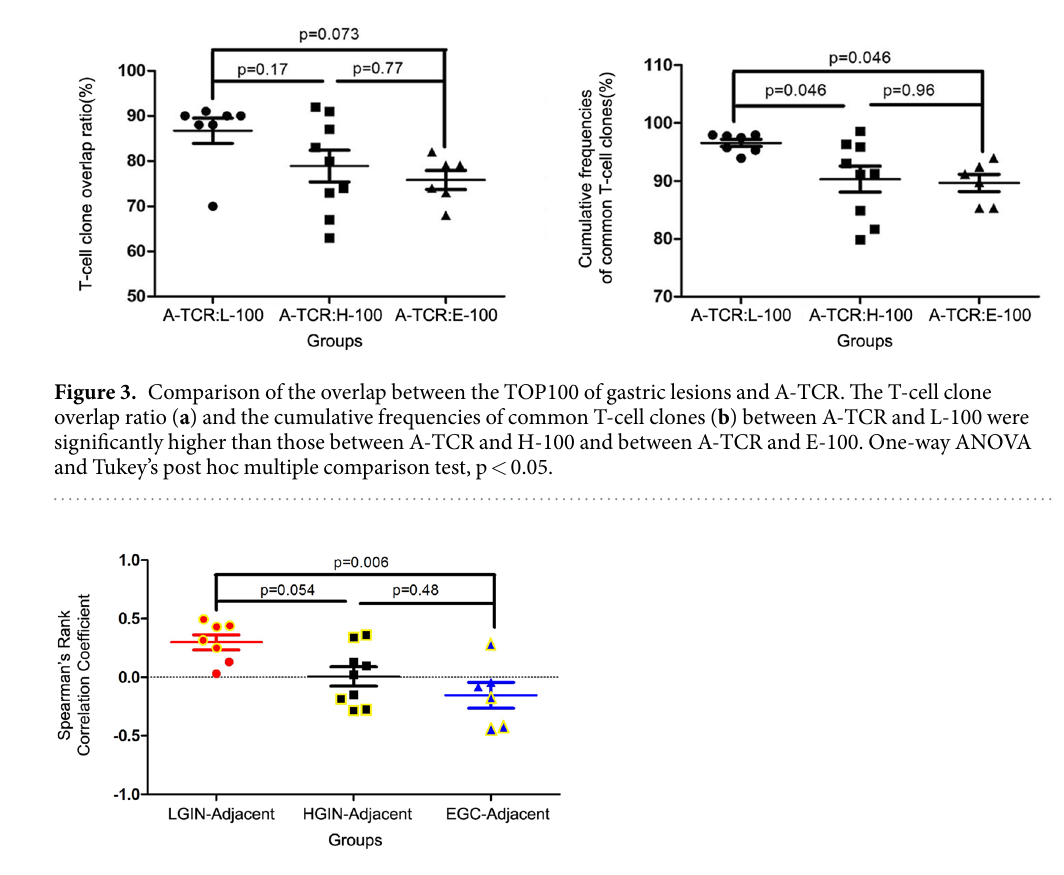
Figure 4. Correlation analysis of “the top 100 common T-cell clones” between gastric lesions and corresponding adjacent tissues. Specifically, LGIN and adjacent tissues showed a positive correlation, but the correlation between HGIN and adjacent tissues was heterogeneous; moreover, most EGC and adjacent tissues showed a negative correlation. One-way ANOVA and Tukey’s post hoc multiple comparison test, p < 0.05. Yellow indicates that the correlation was